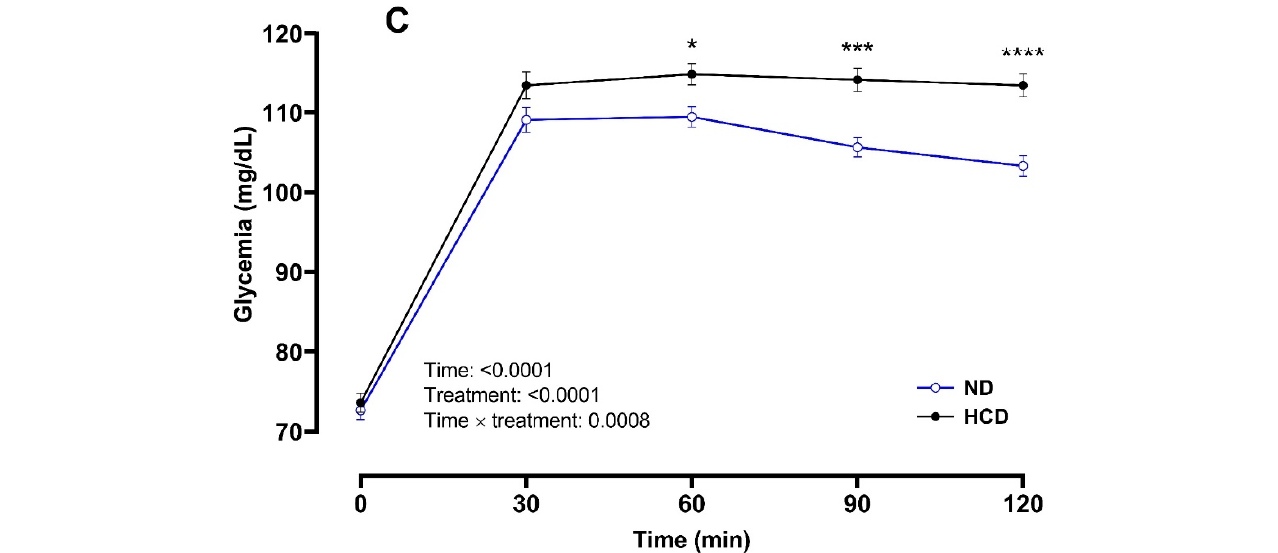
Figure 2. Total energy intake dynamics ( A ) and body weight evolution ( B ) over eight weeks on normal diet (ND) or high-caloric diet (HCD), and glycemic profiles ( C ) during an oral starch tolerance test (OSTT) at the end of the interventions (phase 1). Data are expressed as mean ± SEM. ND ( n = 50) and HCD ( n = 68), Two-way RM ANOVA followed by Sidak’s post hoc test was used. * p < 0.05, ** p < 0.01, *** p < 0.001, **** p < 0.0001.